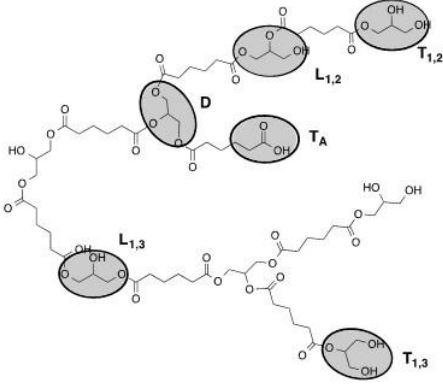
Figure A1. Polymers 2016 , 8 , 192